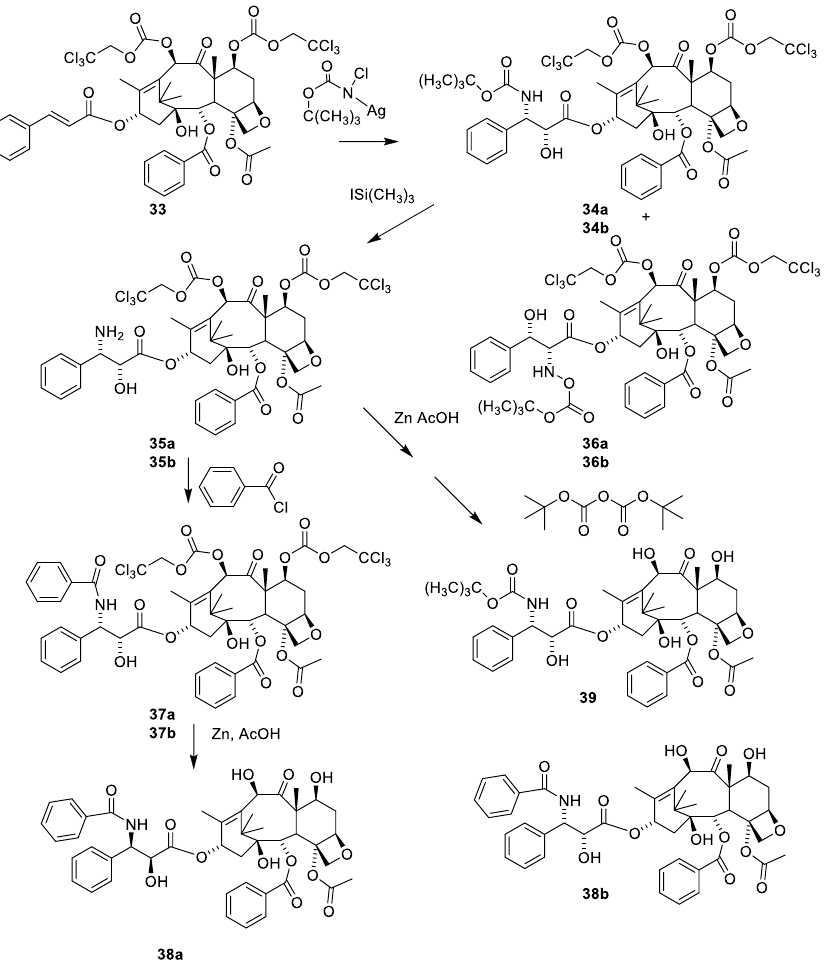
Figure 11. Semi-synthetic preparation of a mixture of regio- and stereoisomers of 10-deactyltaxol ( 38b ). 10-Deacetylbaccatin was protected using Troc at the reactive 7- and 10-hydroxy groups fol- lowed by cinnamoylation with ciannamoyl chloride to give 33 . Sharpless oxyamination of 33 af- fords a mixture of all four possible regio- and stereoisomers 34a , 34b , 36a and 36b . Deprotection of the amino group affords the free amine (e.g., 35a and 35b ), which after bezoylation give benzamide ( 37a and 37b ). Deprotection of the 7- and 10-hydroxy groups afforded 10-deacetyl paclitaxel ( 38b ) [51]. Selective 10-acetylation may be obtained as suggested in Figure 9. Removal of the Troc groups using zinc in acetic acid in methanol from the mixture of the four isomers 34a / 34b and 36a / 36b af- forded four products including docetaxel ( 39 ) [13].